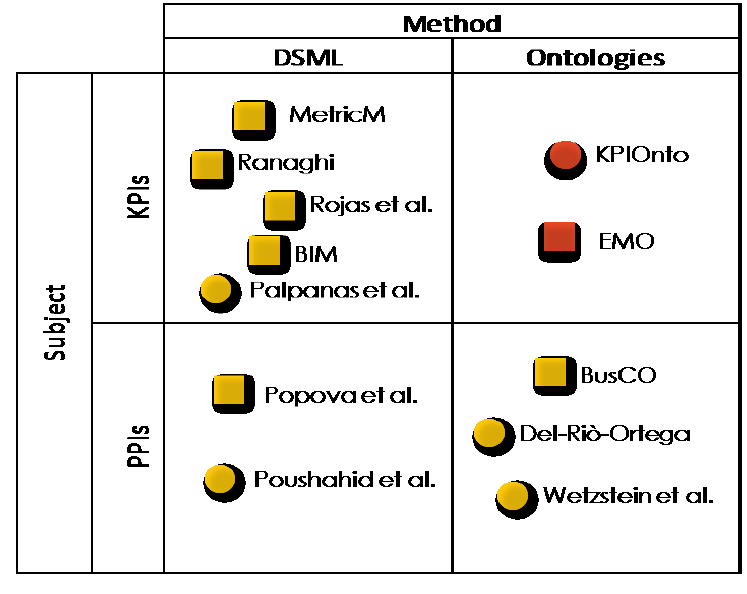
Figure 3. Classification of the works on performance